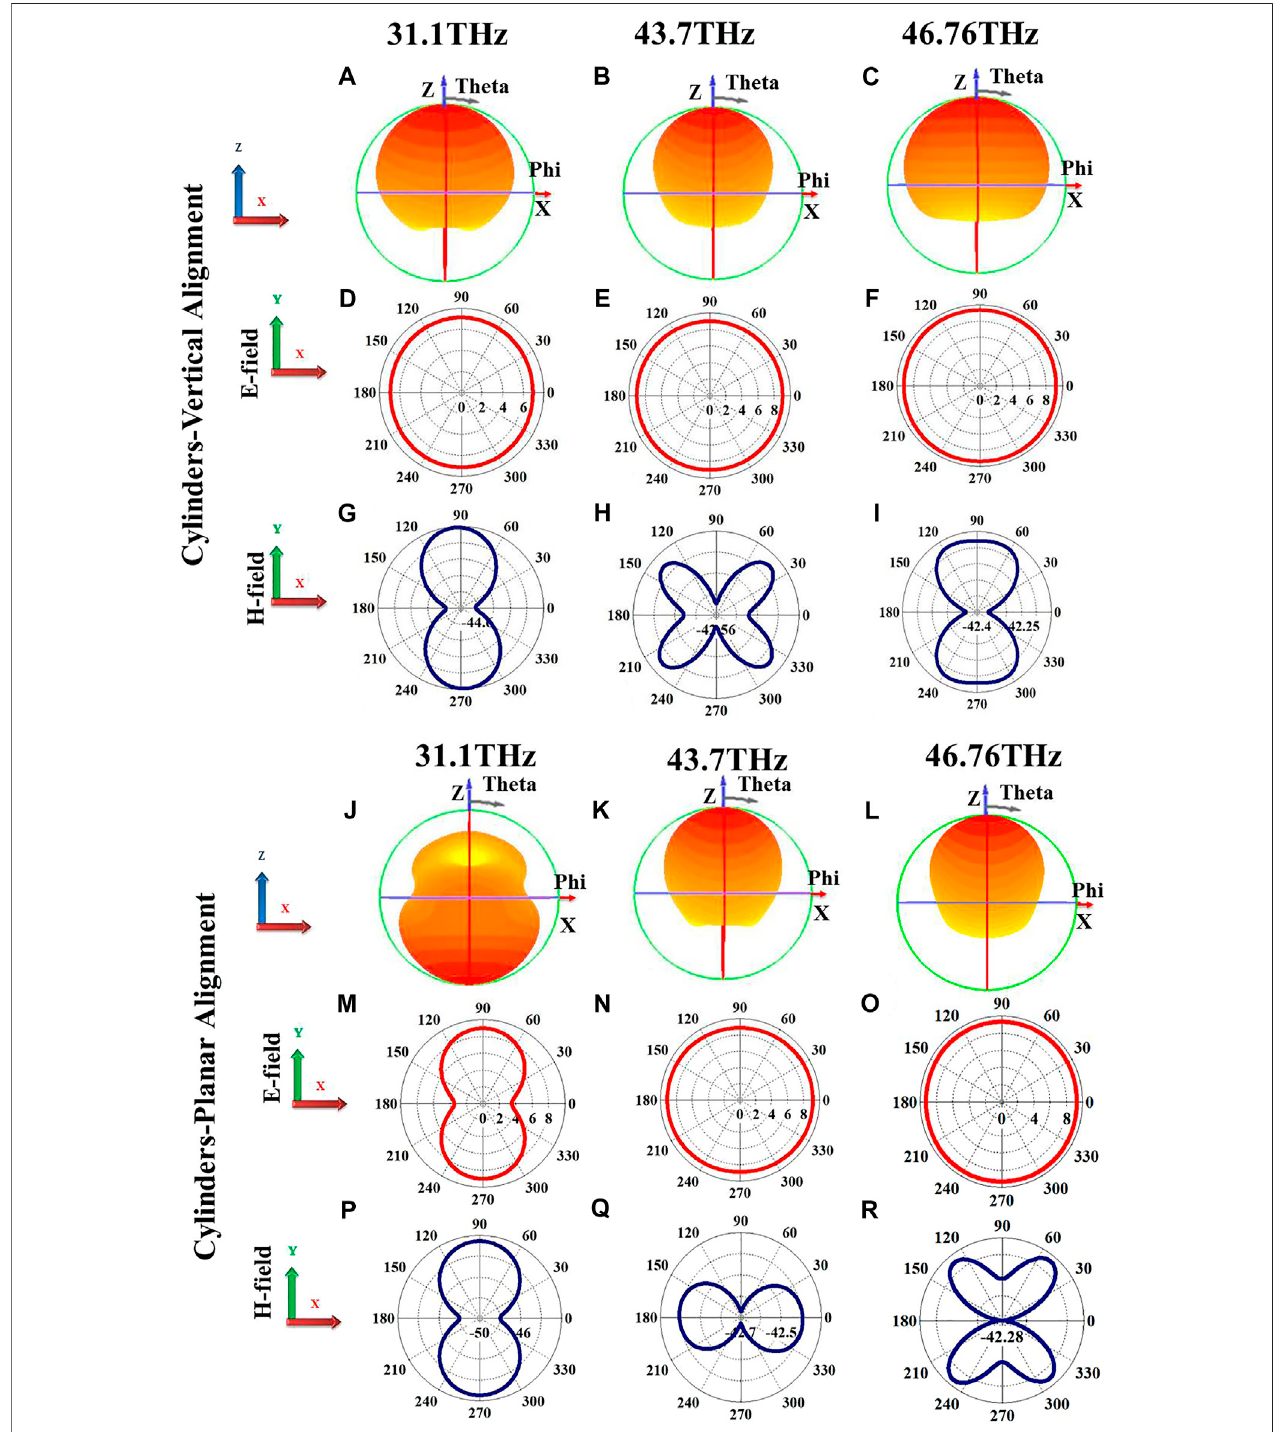
FIGURE 5 | Far- fi eld radiation and angular distribution of electric and magnetic fi elds for cylinders: (A – C) . Far- fi eld radiation in XZ plane at f L , (D – F) . corresponding angular distribution of electric fi eld pro fi les (polarization) in XY plane and (G – I) . Corresponding angular distribution of magnetic fi eld pro fi les in XY plane; (J – L) . Far- fi eld radiation in XZ plane at f H , (M – O) . corresponding angular distribution of electric fi eld pro fi les (polarization) in XY plane and (P – R) . Corresponding angular distribution of magnetic fi eld pro fi les in XY plane, respectively.